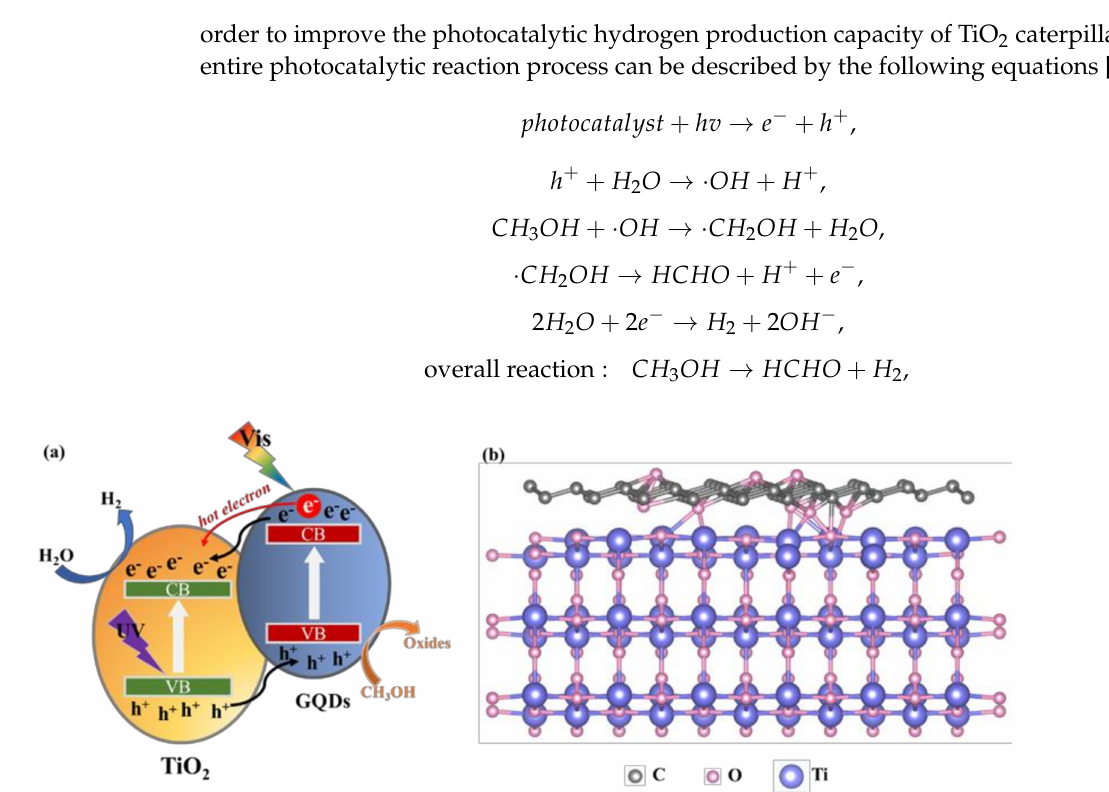
Figure 8. ( a ) Schematic of interfacial carrier transfer mechanism of photocatalytic hydrogen production for TiO 2 -GQDs caterpillar hybrid. ( b ) Schematic model for the C–O–Ti